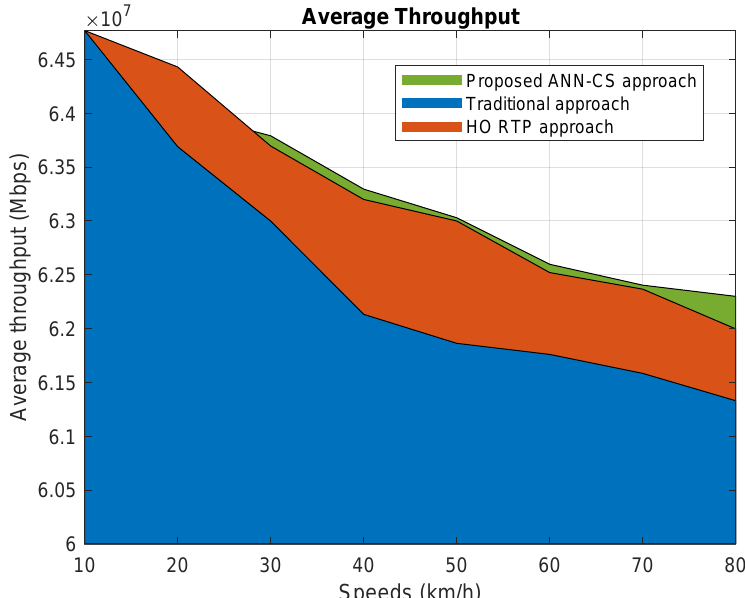
Figure 13. Average achievable downlink